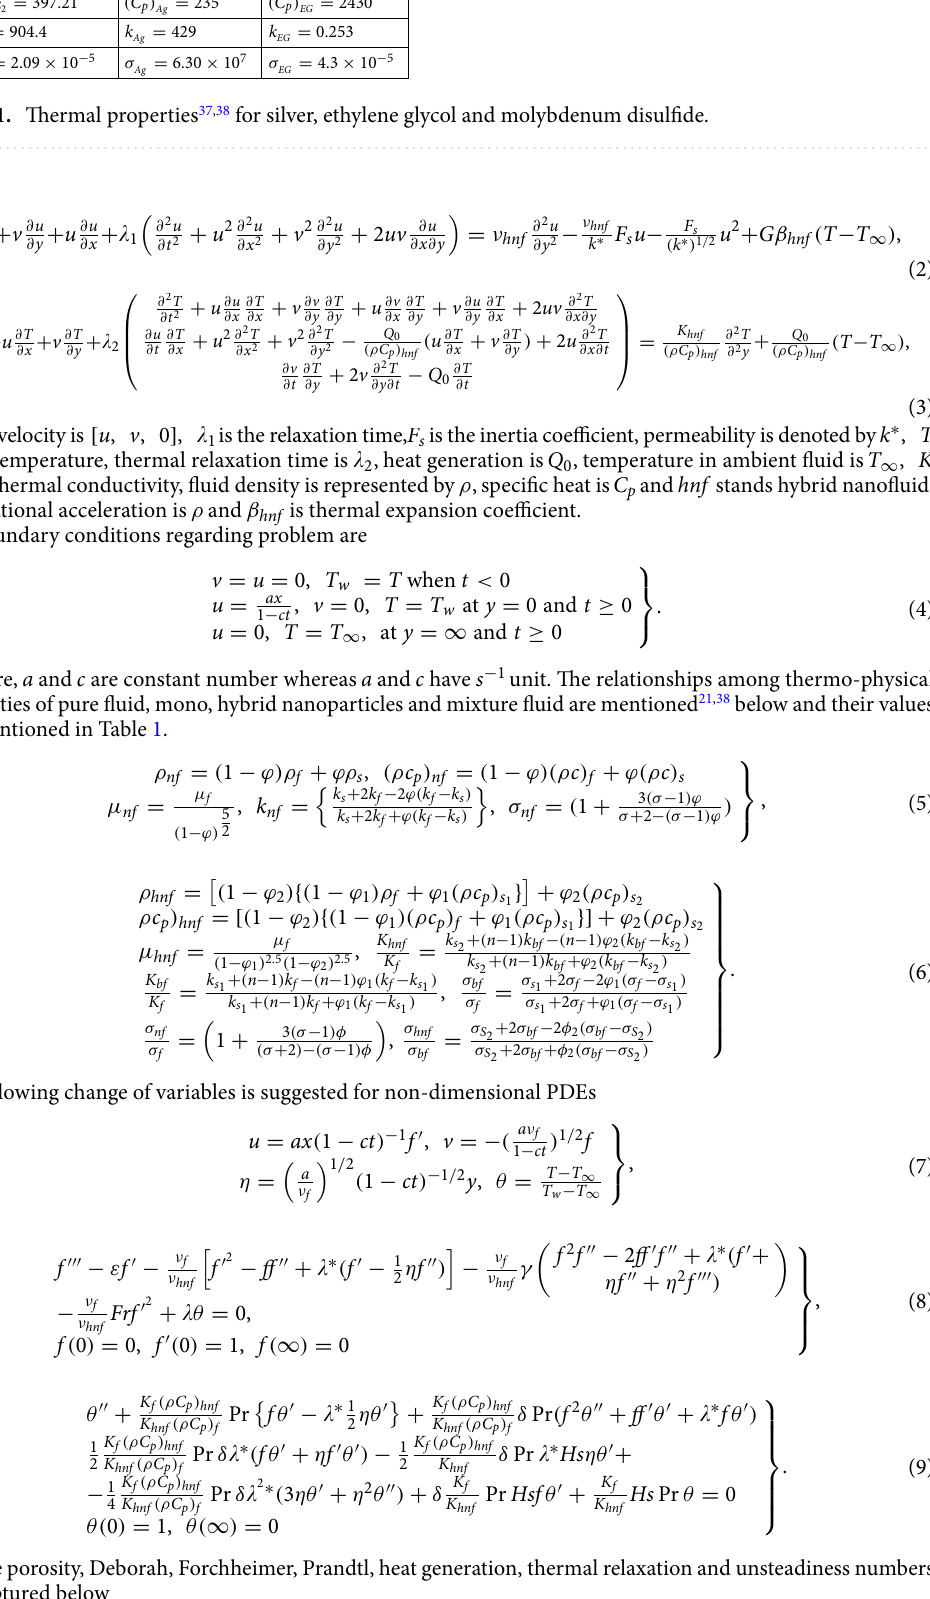
MoS 2 Ag EG 5060 ρ Ag ρ MoS 2 =